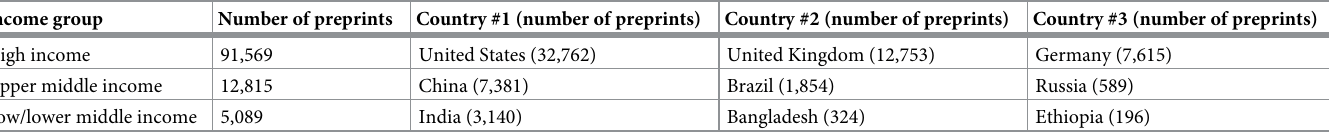
Table 3. Income groups and top countries from each.